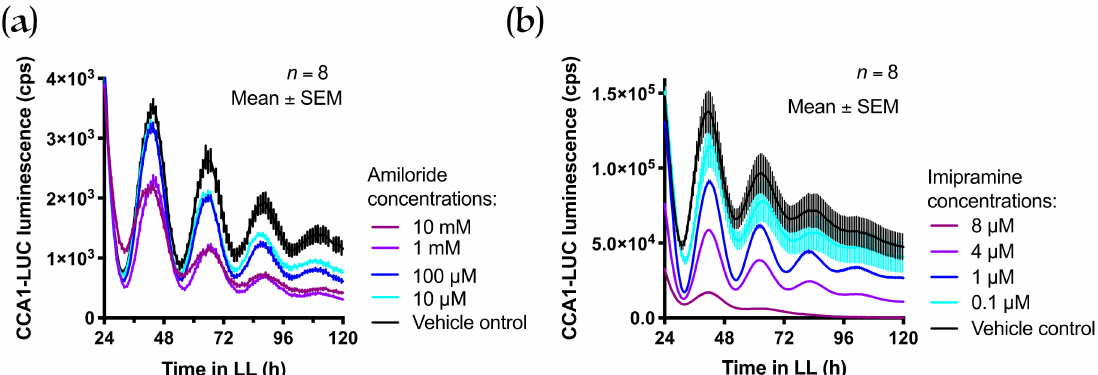
Figure 6. Effect of known inhibitors of SLC41 on CCA1 expression in Ostreococcus tauri . Luminescent traces of the CCA1 bioluminescent line (parent line) at a range of concentrations of ( a ) amiloride or ( b ) imipramine. The graph shows a line through discrete time points at a ~1-h sampling rate (mean ± SEM). LL: Constant